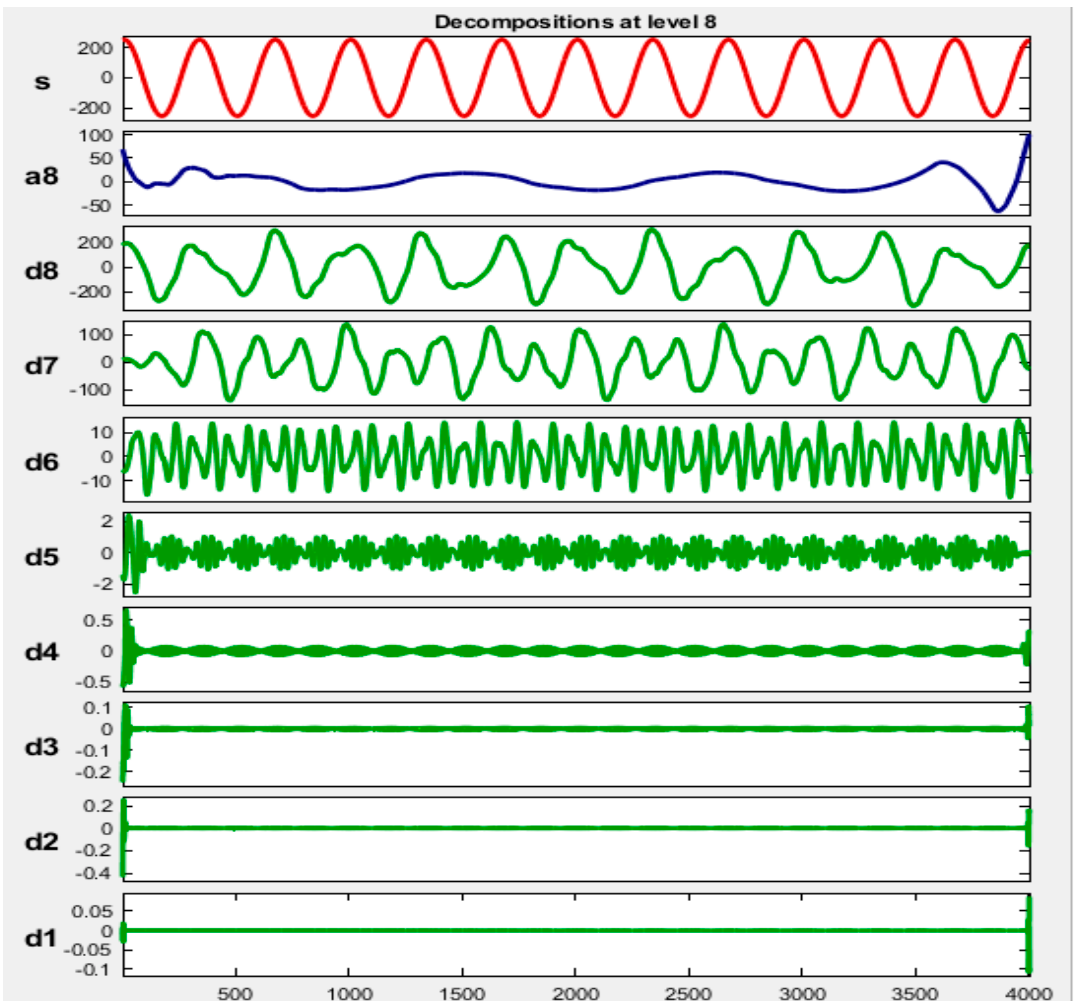
Figure 10. Discrete Wavelet Transform (DWT) analysis of Phase A under normal conditions without compensation.